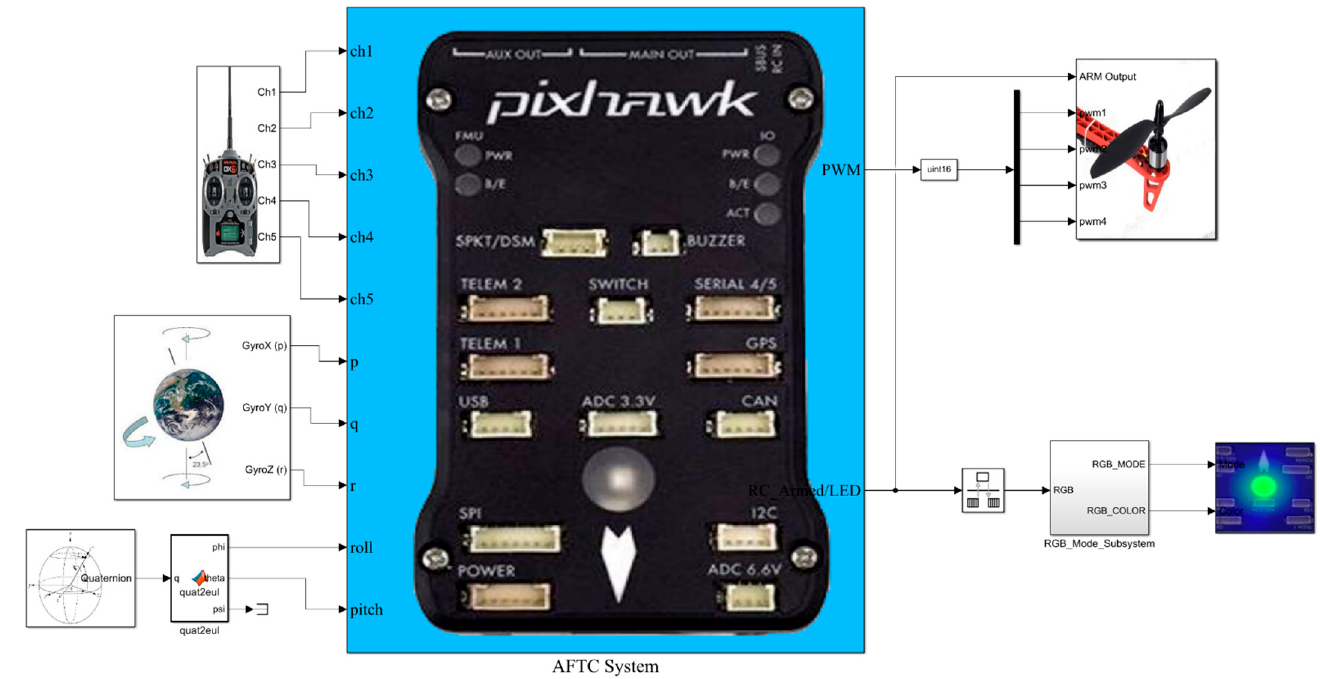
Figure 7. Hardware–in–the–loop simulation model.